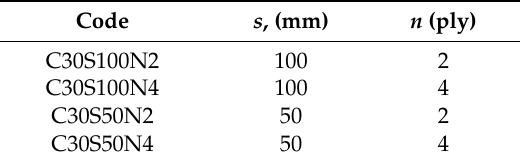
Table 6. Section properties for set 1